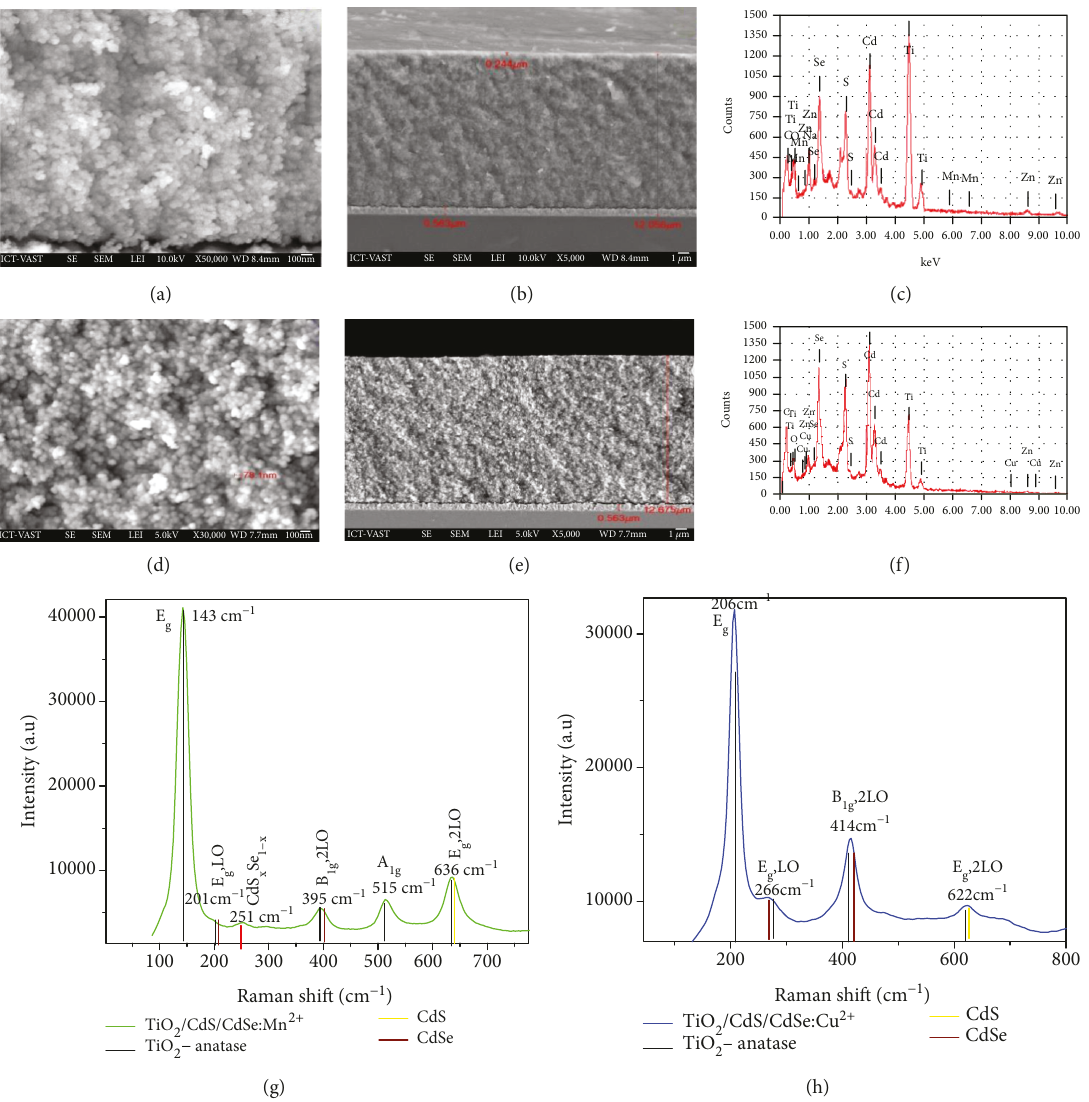
Figure 1: FESEM image at 100nm (a, d) and cross-section at 1 μ m (b, e). EDX of CdSe:Mn 2+ (20%) and CdSe:Cu 2+ (0.3%) (c, f). (g, h) Raman spectroscopy of